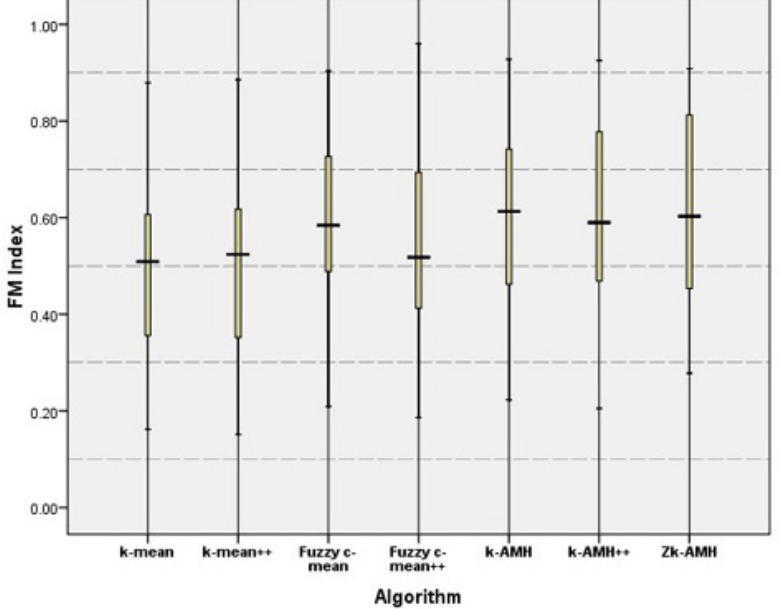
Figure 3. Initial comparison among the k-means, k-means++, fuzzy c-means, fuzzy c-means++, k-AMH numeric, k-AMH numeric++, and Zk-AMH algorithms for the combination of all eight datasets